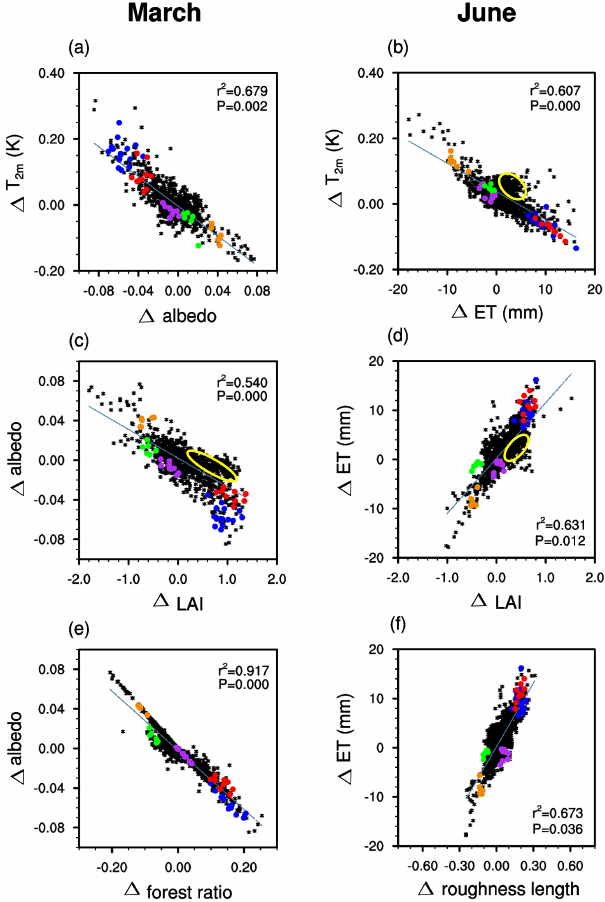
Figure 8. Spatial correlations between (a) changes in monthly- averaged daily mean 2m air temperature ( T 2m ) and changes in albedo for March, (b) changes in T 2m and changes in ET for June and relationships between changes in land surface parameters in REMO LSS following land cover changes and changes in albedo (c, e) (changes in ET, d , f ) in the corresponding month. The changes in the grid boxes in selected subregions are shown with coloured dots (subregion1 – blue; subregion2 – red; subregion3 – purple; subre- gion4 – green; subregion5 – orange). The grid boxes in yellow cir- cles show the changes in the southeast area of